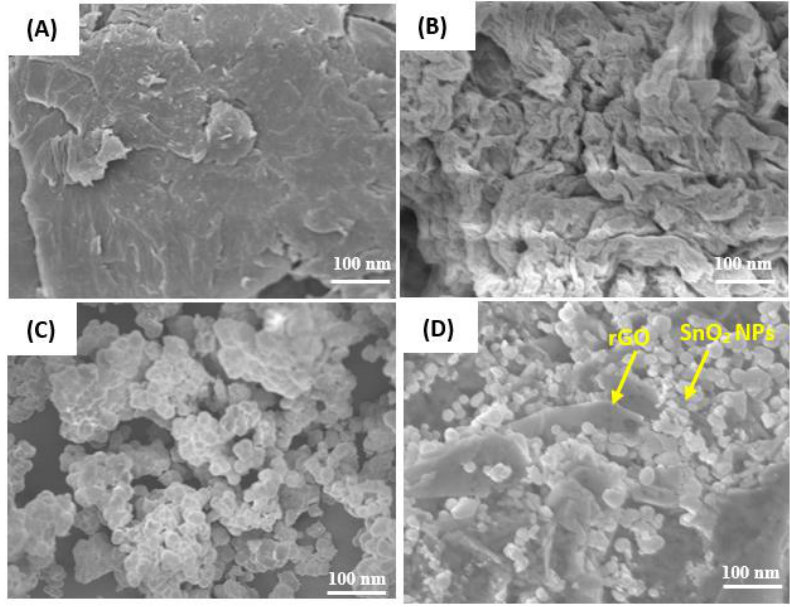
Figure 3. FE-SEM images of GO ( A ); rGO ( B ); SnO 2 NPs ( C ); SnO 2 -rGO NCs ( D ).